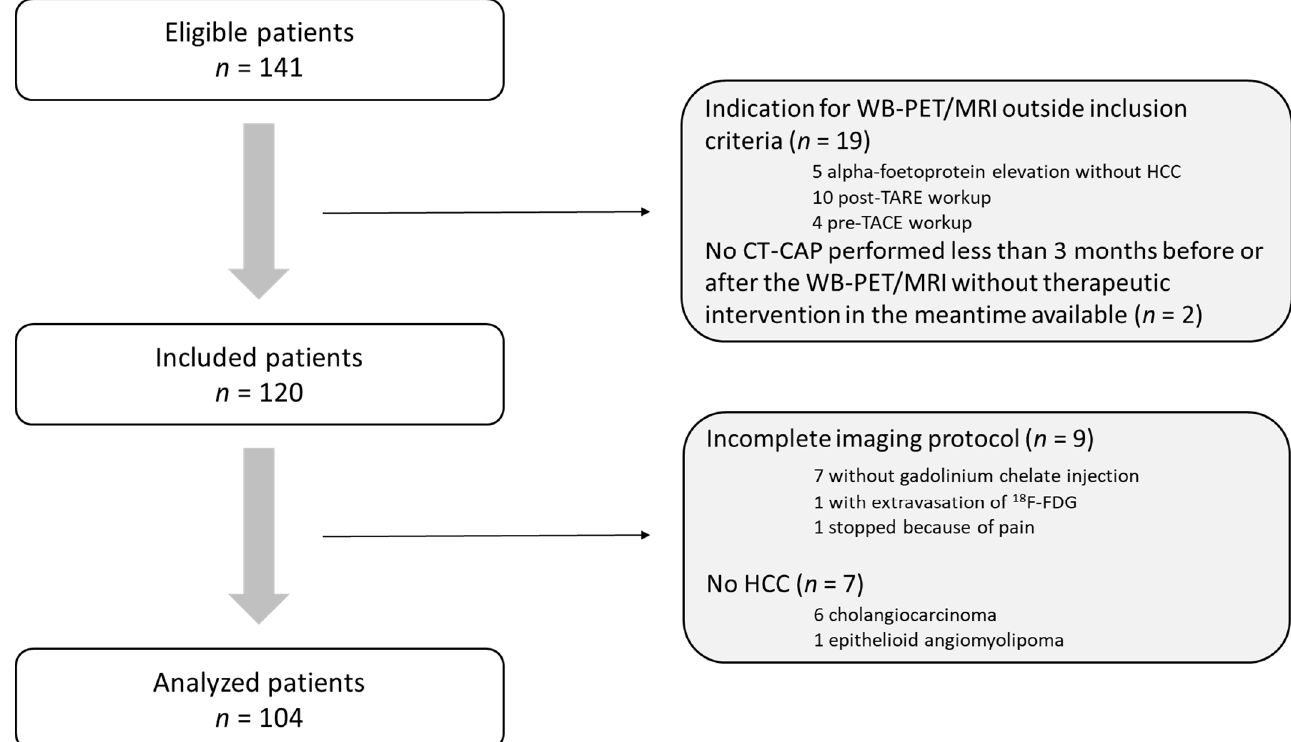
Figure 1. Flow Chart.